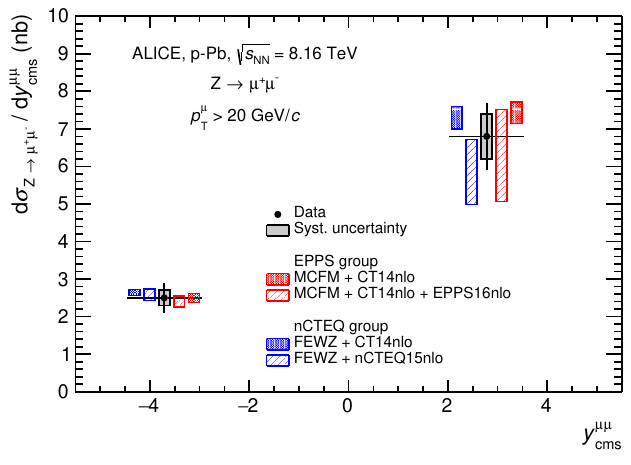
Figure 2 . Production cross section of (cid:22) + (cid:22) (cid:0) from Z-boson decays, measured in p-Pb collisions p at s NN = 8 : 16 TeV and compared with theoretical calculations both based on CT14 (at NLO) free-nucleon PDFs [50] and on other PDF sets including the presence of a nuclear modi(cid:12)cation. The horizontal extension of the data points correspond to the measured rapidity range. The bars and boxes correspond to the statistical and systematic uncertainties respectively. The theory points are horizontally shifted for better